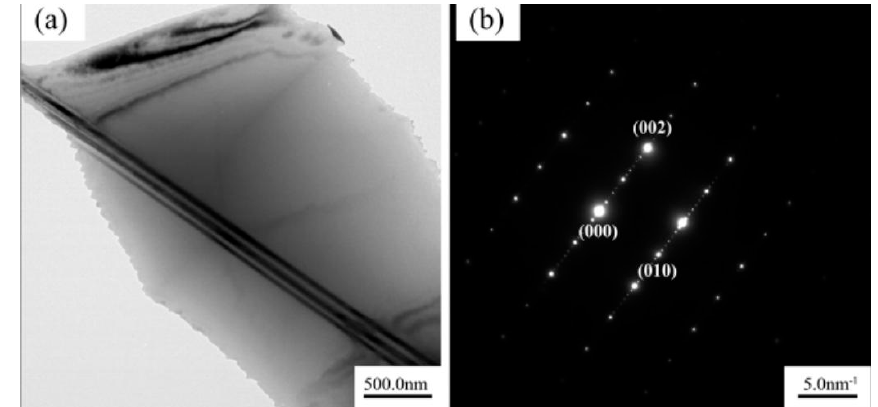
Figure 9. ( a ) TEM bright field image ( b ) SAED.